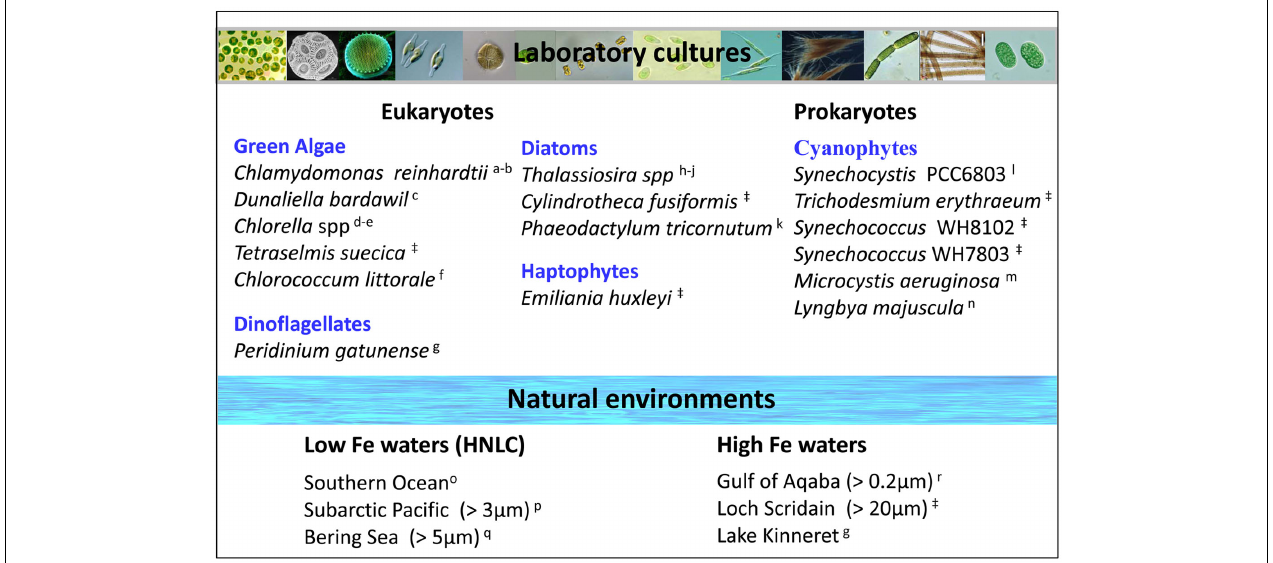
FIGURE 3 | Prevalence of the reductive iron uptake pathway amongst phytoplankton. Listed are laboratory cultures and natural environments for which inhibition of uptake by Fe(II) binding ligands (Ferrozine/BPDS) was observed experimentally and taken to indicate the formation of an Fe(II) intermediate during iron transport. For some species, genomic and proteomic research identified various components of the reductive iron uptake pathway including ferrireductases and multicopper oxidases. See Appendix for supporting data and methodology ( TablesA1 and A2 and FiguresA1 and A2 in Appendix). Note on locations:The Gulf of Aqaba is located at the northern